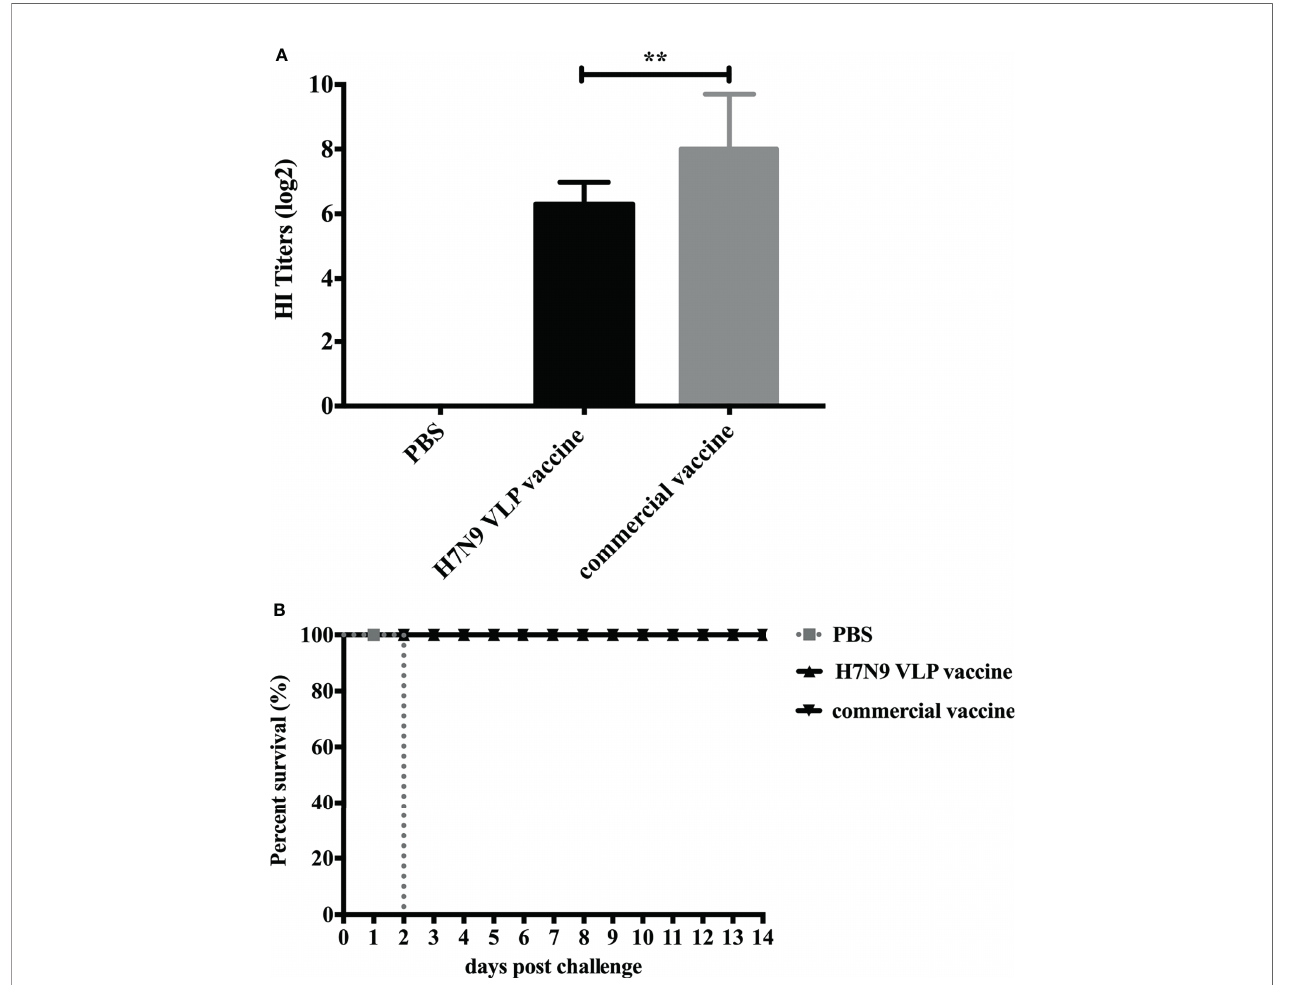
FIGURE 4 | Hemagglutinin inhibition (HI) titers of SPF chickens after immunization and survival rates of SPF chickens after challenge. (A) The SPF chickens were immunized with the H7N9 VLP vaccine and the H7N9 commercial vaccine. The serum samples were collected at 3 weeks postvaccination to measure the HI antibody titers. The HI titers of SPF chicken sera were measured with 4 HAU testing antigens of the H7N9 GD16 virus. The HI titers among vaccination groups were compared using one-way ANOVA followed by Tukey ’ s multiple-comparison test. ** p < 0.01, statistically signi fi cant differences. (B) At 3 weeks postvaccination, groups of SPF chickens ( n = 10) were intranasally challenged with a high lethal dose (2 × 10 6.0 ELD 50 ) of A/Chicken/Guangdong/GD16/2016 H7N9 AIVs. Survival rates of chickens were measured daily for 2 weeks after challenge.